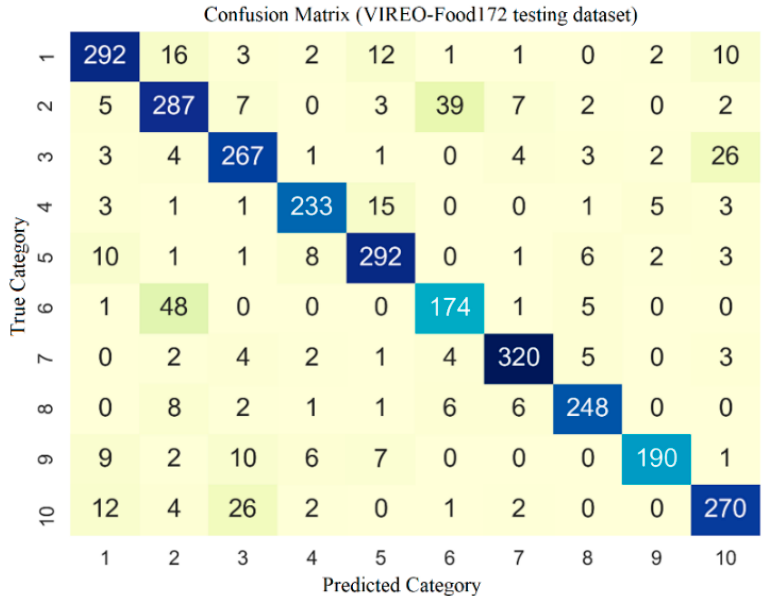
Figure 6. Confusion matrix of EFFNet + SVM (OVO) applied on VIREO-Food172 testing set.